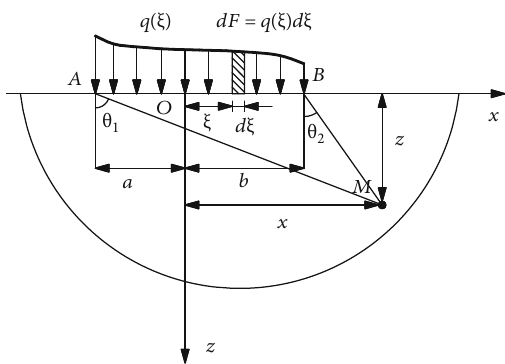
Figure 3: The mechanical models of a semi-in fi nite solid subjected to distributed load on the